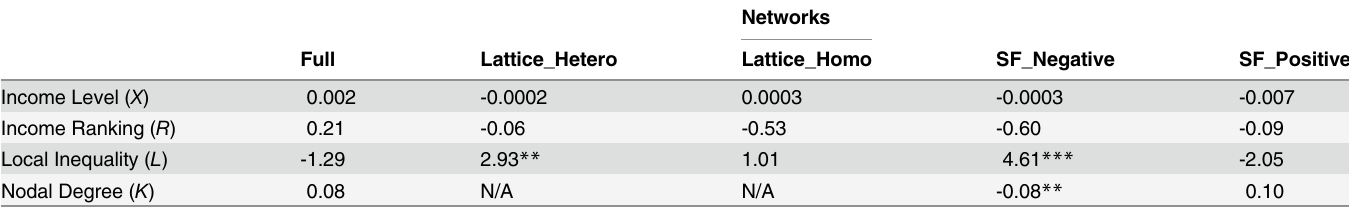
Table 2. Hurdle Regression Model on Giving Decisions (Amount of Giving).